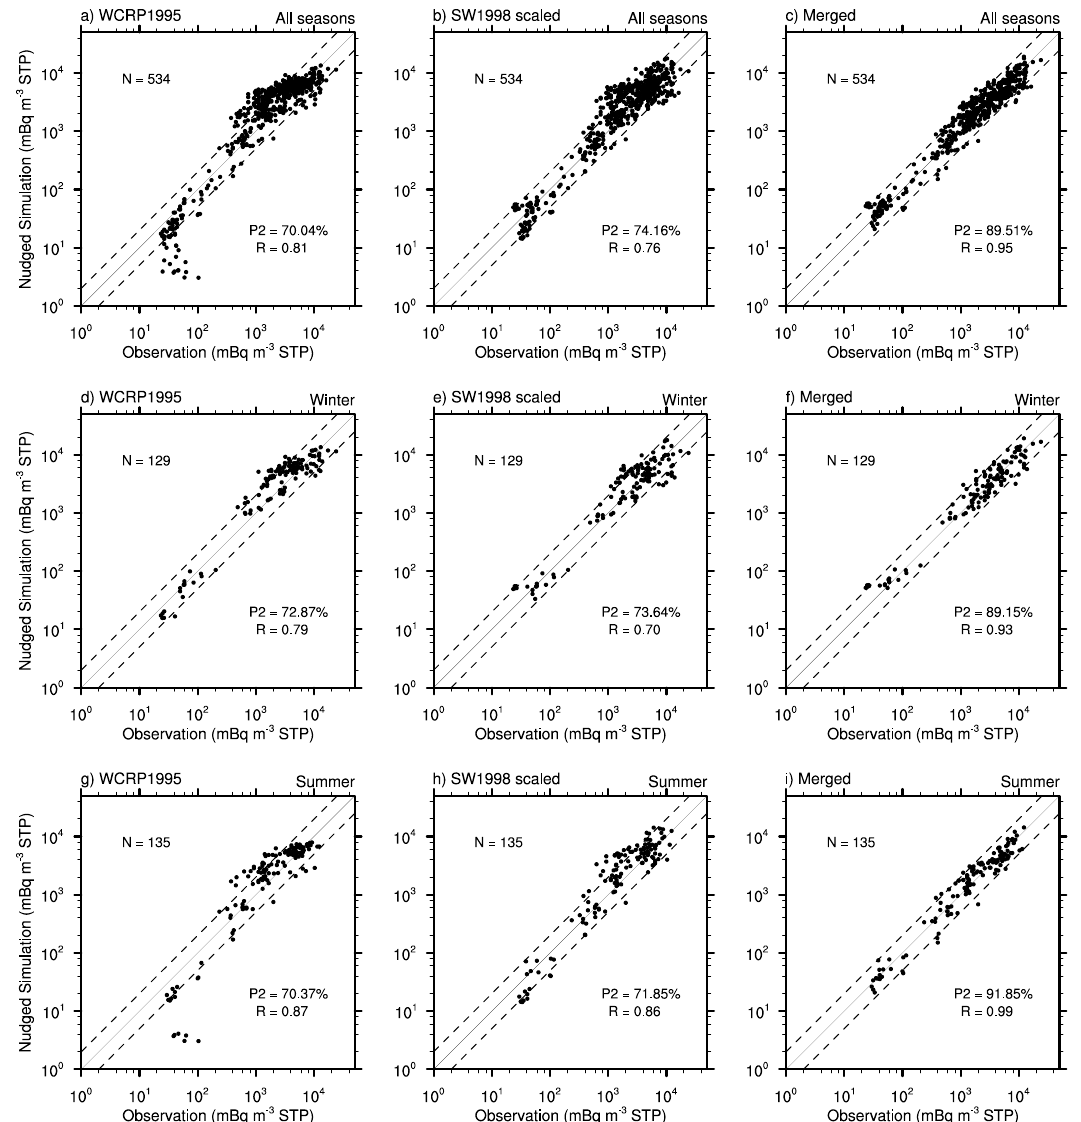
Fig. 4. Scatter plots of the simulated and measured monthly or seasonal mean surface radon concentration (mBqm − 3 STP) at the 51 sites listed in Table 2 and shown in Fig. 3. The three columns correspond to simulations using the WCRP1995 recommended radon emission (left), the SW1998 emission maps scaled by a factor of 1/1.6 (middle), and the new emission maps prepared during this study. The first row contains results of all months/seasons (534 samples); The second row shows the 129 winter samples (DJF in the Northern Hemisphere, JJA in the Southern Hemisphere), and the third row shows only the 135 summer samples (JJA in the Northern Hemisphere, DJF in the Southern Hemisphere). The dashed lines indicate the range within a factor of 2 of the measurements. Also shown in each panel are the percentage of samples within this range (the P2 values) and the correlation coefficients between simulation and observation (the R values).